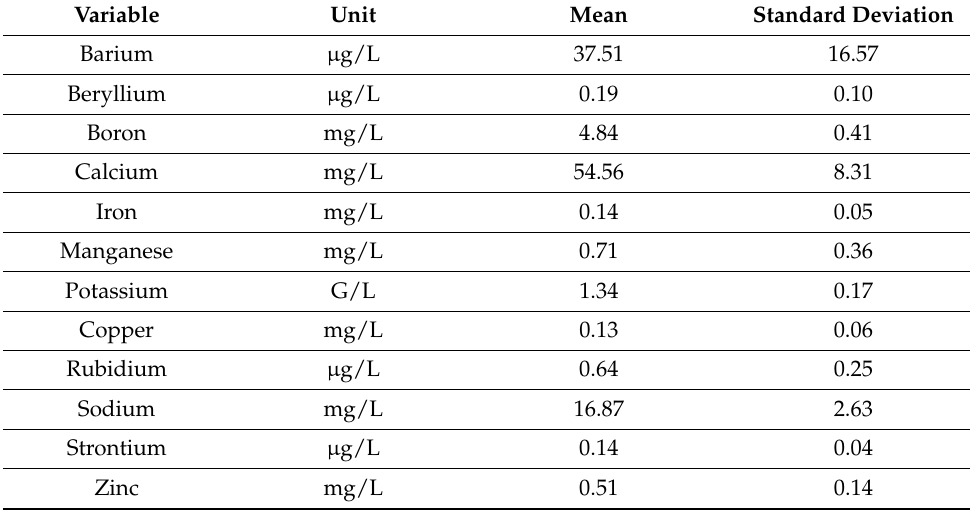
Table 6. Means and standard deviations of mineral elements in wine (see Table S2 in the Supplementary Materials).